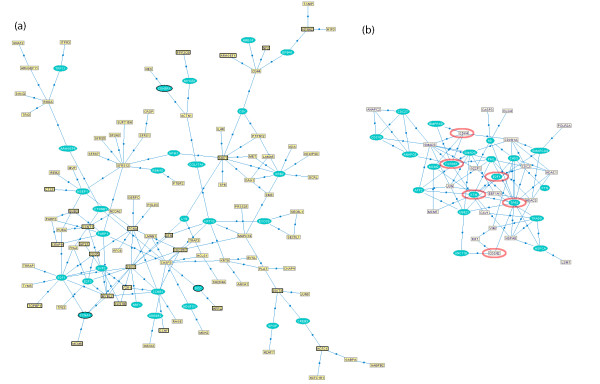
Examples of the MATISSE analysis in the cell cycle data of human HeLa cells. Front nodes and back nodes are as indicated in Figure 4. (a) The highest scoring cell-cycle related JACS identified. The genes annotated with "cell cycle" are drawn with thicker border. Gene lists, expression matrices and interactive display of all the subnetworks are available at the supplementary website, (b) Subnetwork hubs. The figure shows 36 nodes in the JACSs that were identified as subnetwork hubs and induced a connected component in the network. 16 additional hubs that had no interactions with other hubs are not shown. The known master regulators p53, ATM, E2F1, TGFβR, CDK4 and CDC42 are circled.